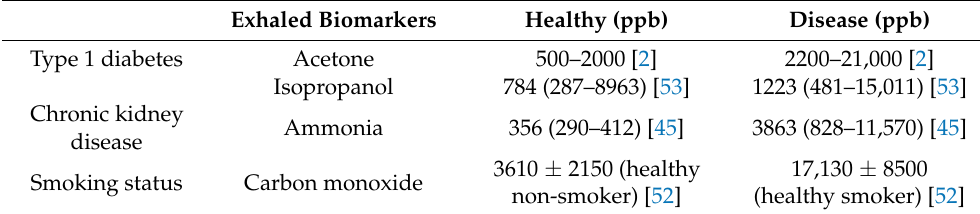
Figure 5. ( a ) Transient responses of RGO–MnTPP, –ZnTPP, –FeTPP, and –CoTPP were plotted when subjected to 5 ppm of ammonia. ( b ) A radar plot shows the sensing responses of the RGO–metalloporphyrin-sensing array for acetone, iso- propanol, ammonia, and carbon monoxide.